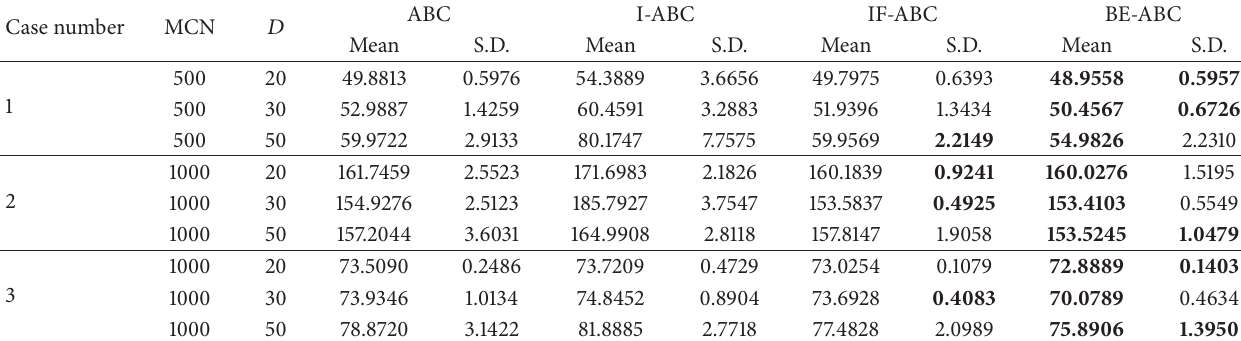
Table 2: The mean and standard deviations of cost function